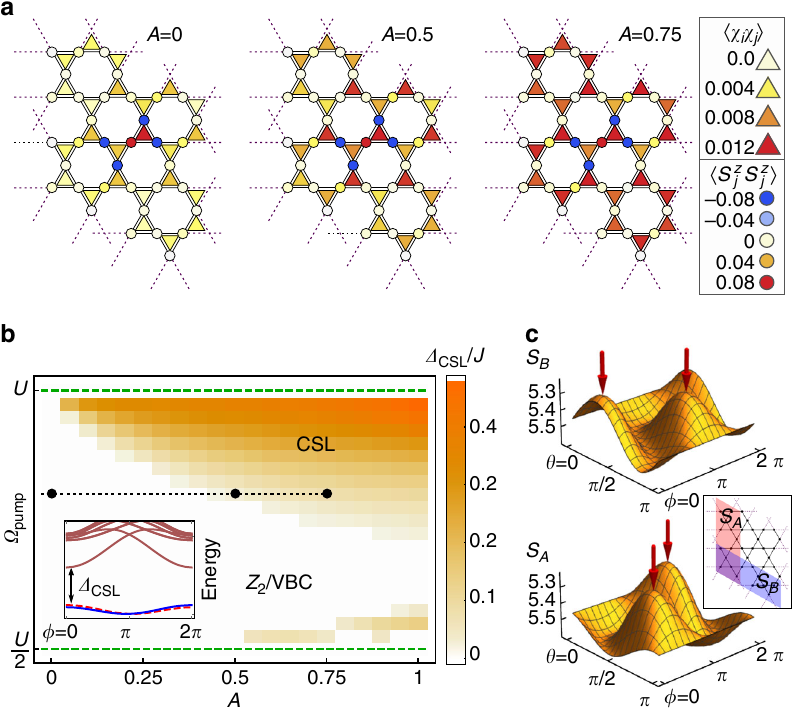
(cid:12) (cid:11) (cid:12) (cid:11) ( triangles ) ( circles on vertices) and chiral S i (cid:3) S j ´ S k ð Þ½ (cid:7) S l (cid:3) S m ´ S n ð Þ½ (cid:7) Fig. 3 Identi fi cation of a photo-induced chiral spin liquid. a Evolution of spin S i (cid:3) S j correlation functions as a function of pump strength A , from 36-site exact diagonalization of Eq. (3). b Minimum chiral spin liquid (CSL) excitation gap Δ fl ux insertion through the torus. Inset depicts the twofold quasi-degenerate ground states ( blue and CSL above twofold degenerate ground states, under dashed-red lines ) and gap to excited states ( brown lines ), as a function of fl ux ϕ threaded through the torus (Methods section). The equilibrium ground state (a putative Z 2 spin liquid or valence bond crystal) transitions into a photo-induced CSL at fi nite pump strength. c Rényi entropies and entanglement minima, of CSL ground state superpositions cos ð θ Þ ψ 1 j i þ sin ð θ Þ e i ϕ ψ 2 j i for two bipartitions of the 36-site torus (inset), discussed in the main